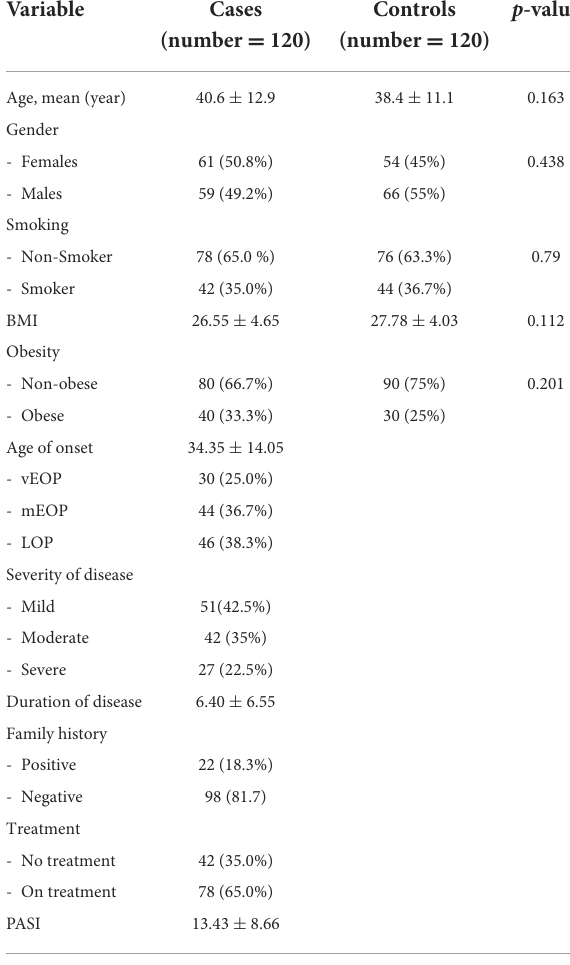
TABLE 2 Baseline and clinical characteristics of the research